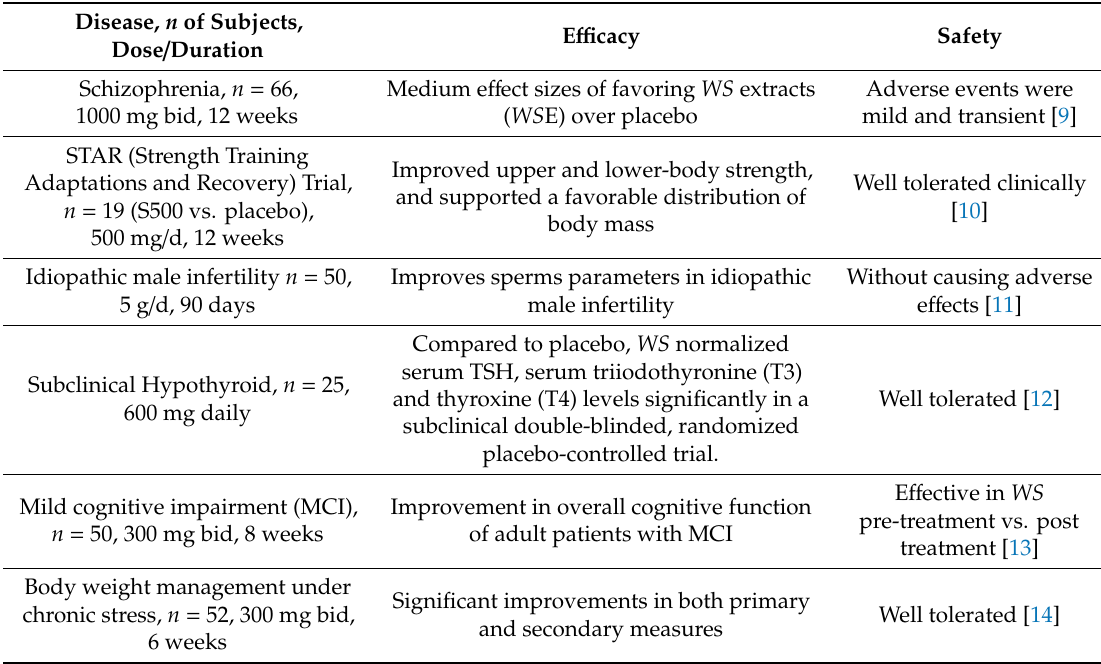
Table 1. Randomized Double-Blind Placebo Control Trials Involving Withania Somnifera (WS )